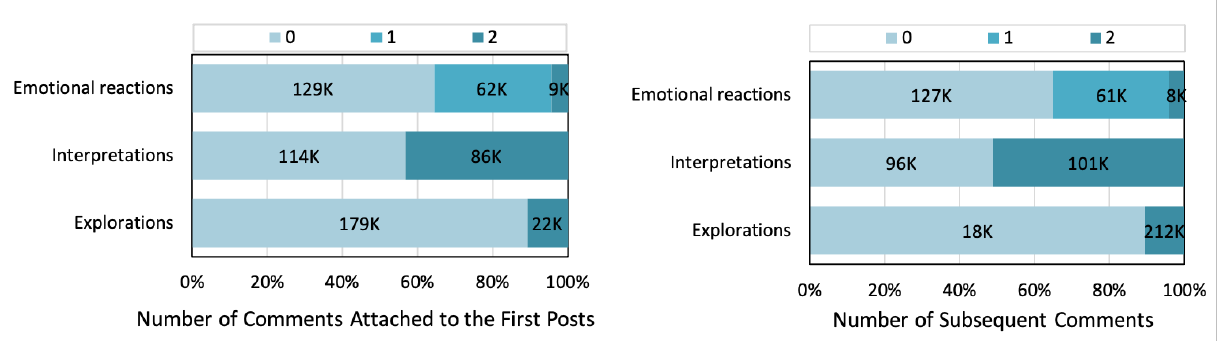
Figure 2. Empathy level of comments attached to users’ first posts ( left ) and users’ subsequent comments ( right ) in each